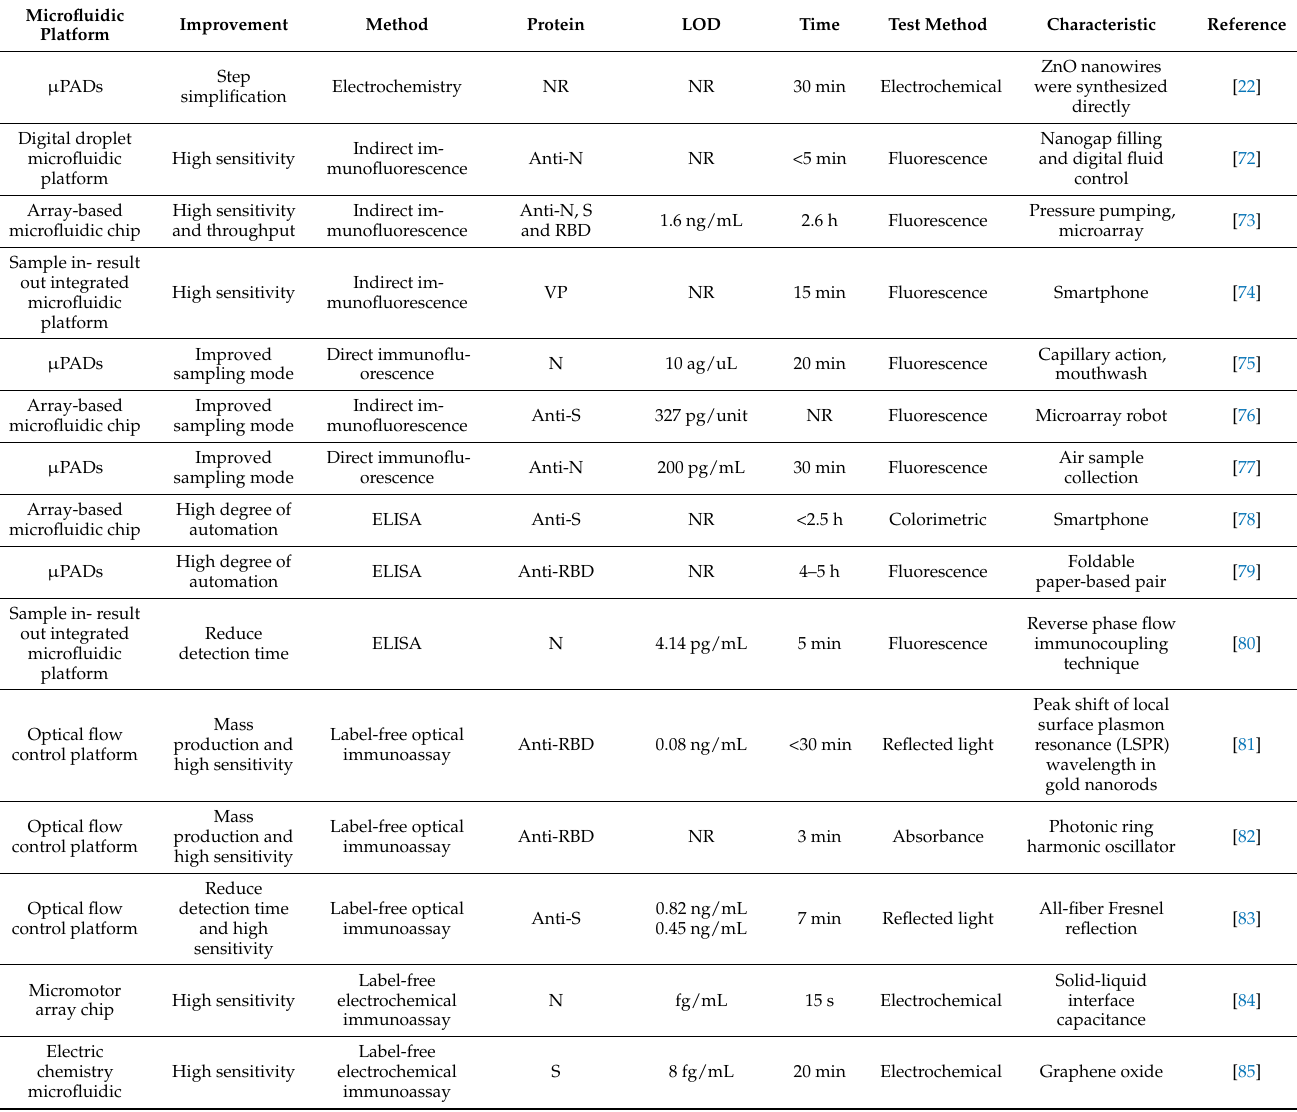
Table 2. Microfluidic immunoassays for the detection of SARS-CoV-2